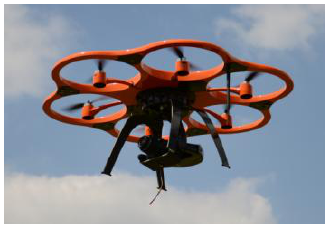
Figure 2. Aibotix X6V2 UAV with Nikon camera